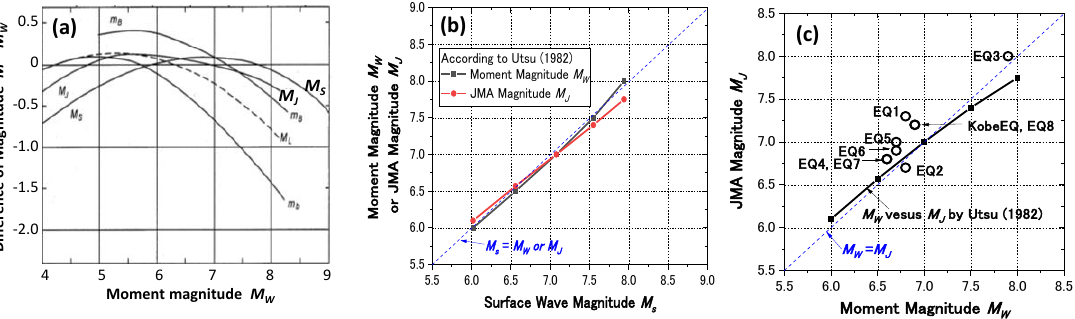
Figure 17. Mutual relationships among different magnitudes: relationships among various magni- tudes modified from Utsu 1982 [23] ( a ). Relationship between Surface Wave Magnitude Ms versus Moment Magnitude M W or JMA Magnitude M J [23] ( b ). Direct relationship between M W and M J [23] compared with the magnitudes announced for the nine earthquakes ( c ).